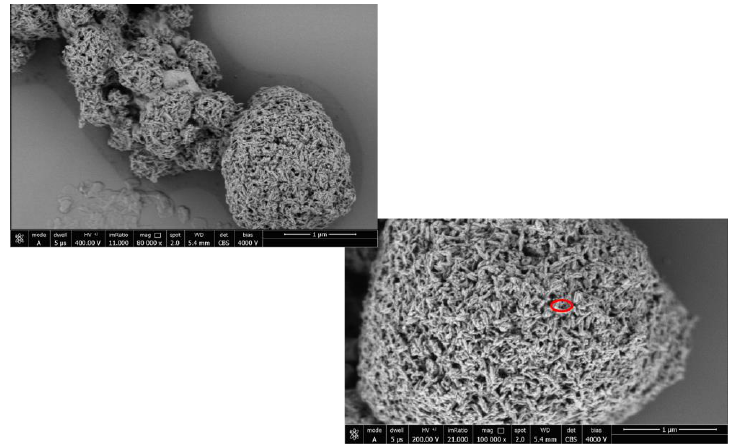
Figure 2. SEM image of the complex Hp φ + LF-HA. The phage’s capsid is represented as the light point (red square) on the HA nanocrystal. point (red square) on the HA